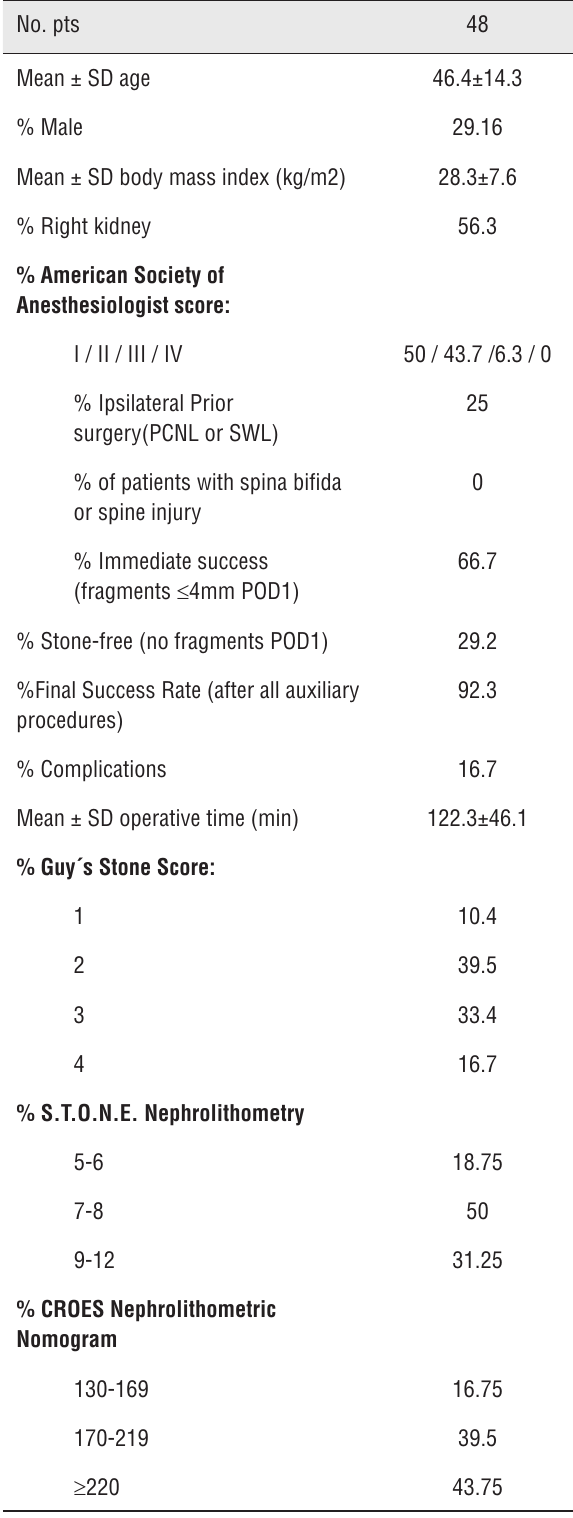
Table 1 – Baseline characteristic of study